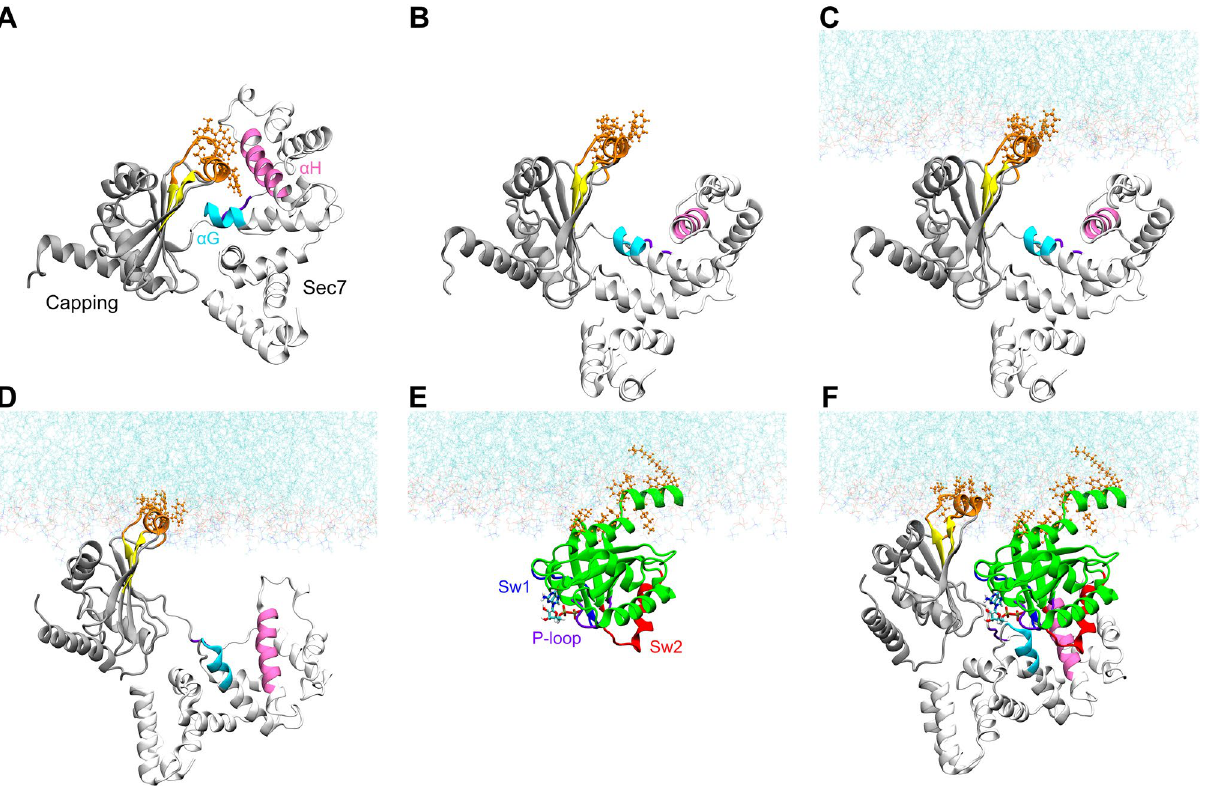
Figure 2. Structures from the different phases of the modelling process: ( A ) autoinhibited, closed RalF; ( B ) partially open RalF retrieved after the filtering of the first conformational mapping step; ( C ) partially open RalF obtained previously anchored to the membrane; ( D ) open RalF attached to the membrane retrieved by MDeNM starting from the anchored structure shown in ( C ); ( E ) the modeled membrane-anchored, myristoylated, full- length Arf1; and ( F ) the relaxed, membrane-attached RalF-Arf1 complex. RalF Sec7 is represented in white denoting the Arf1 binding site by cyan (αG) and mauve (αH). The Capping domain is represented in grey. Arf1 depicted in green, switch1 in blue, switch2 in red, and P-loop in purple. The GDP nucleotide is in licorice representation, the membrane-binding residues are in